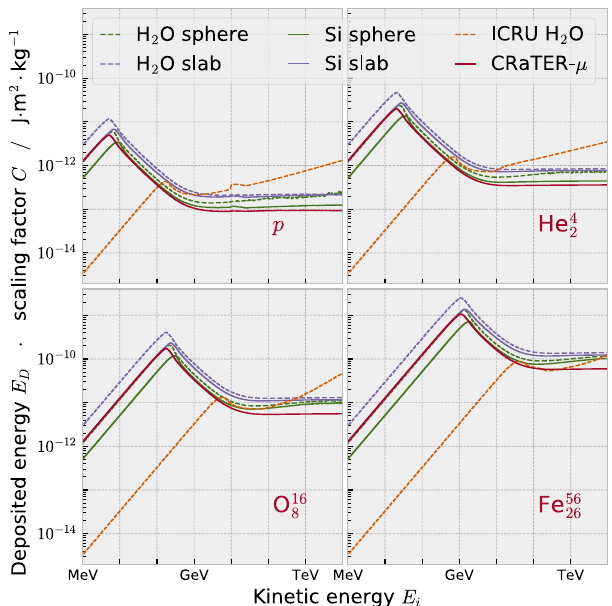
Fig. 2. Deposited energy multiplied by factor C (Eqs. (2), (3) and (4)) takes in to account the fact that the phantoms have different masses and sizes. The analysis shown here is reduced to four GCR species: protons, and He, O and Fe nuclei. After the re-scaling, we can compare the relative differences in absorbed dose rate that the phantoms would suffer if they were placed in to the same radiation fi eld. We see that the the relation between phantom size, shape and measured dose has a non trivial dependence on particle type and energy. The calculated data indicates that the smaller slab and sphere phantoms suffers a higher absorbed dose for most particle types and energies.